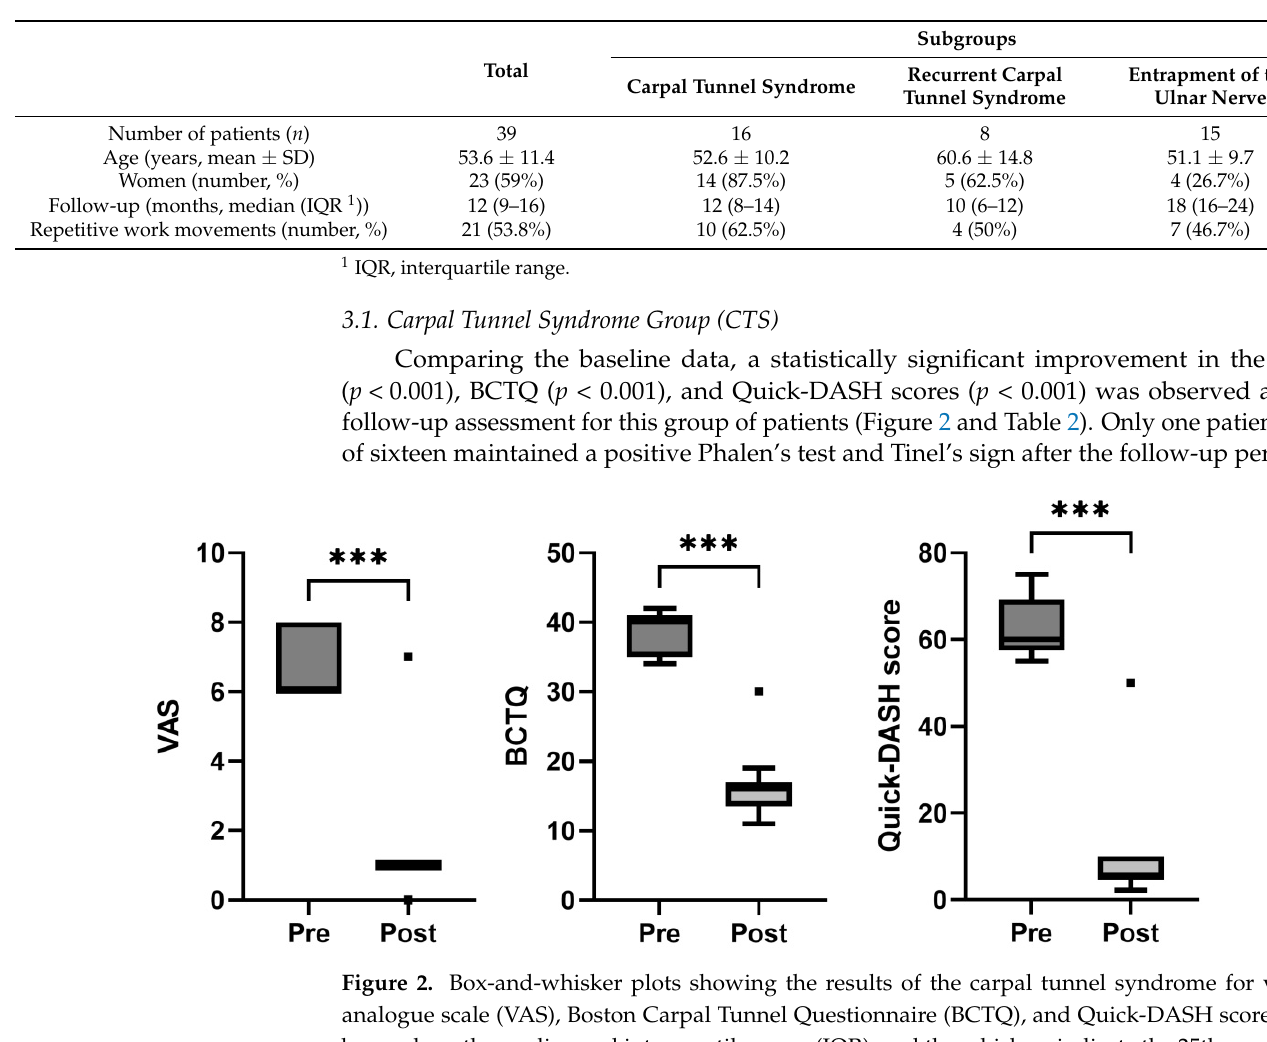
Table 1. Demographic characteristics of the patients.